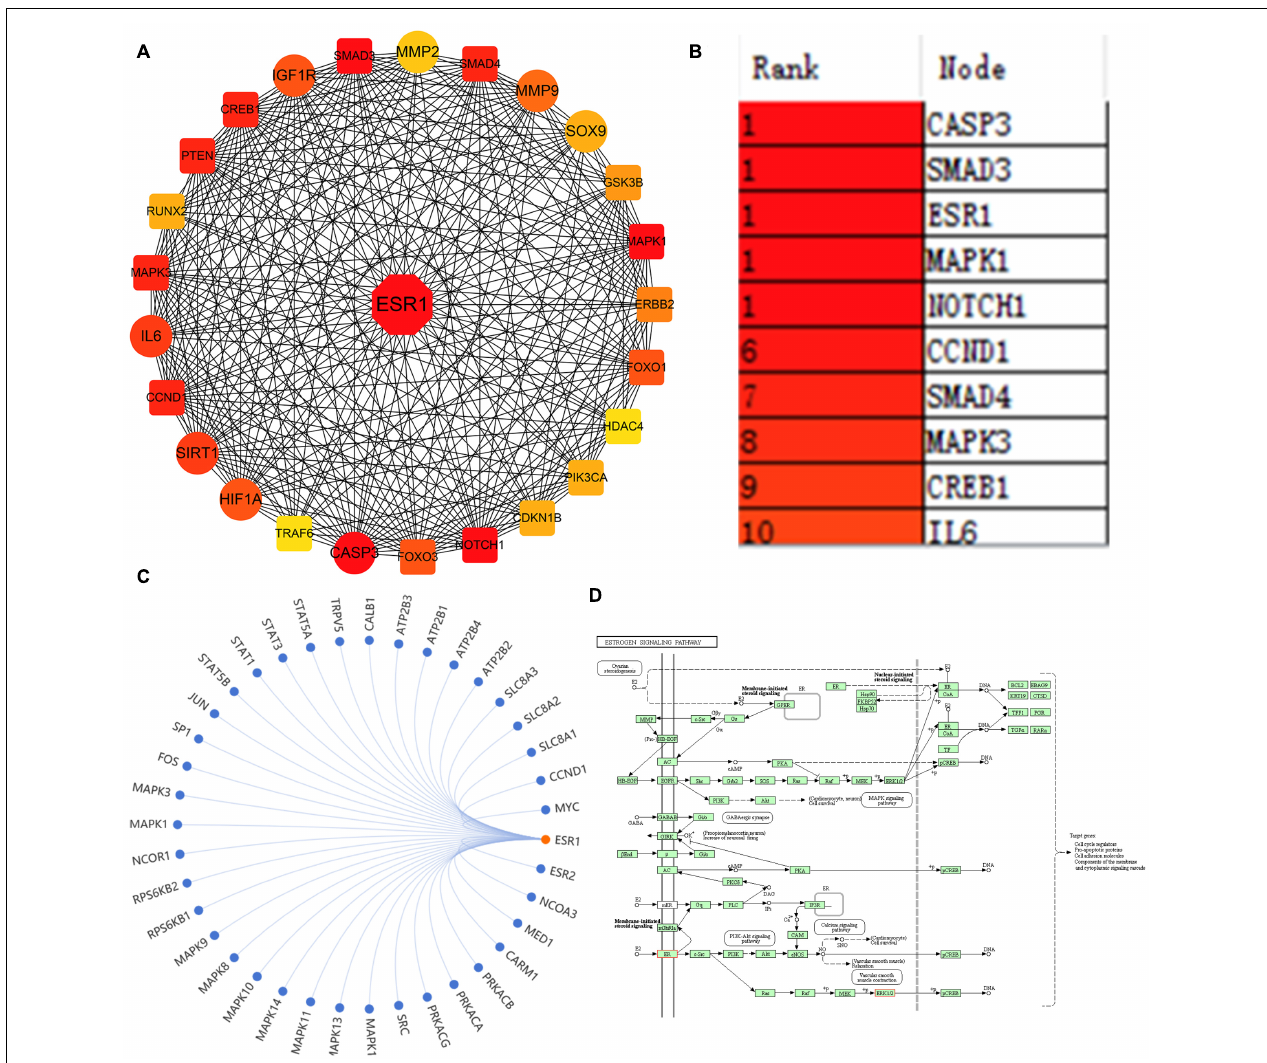
FIGURE 1 | ESR1 was identified as one of the most critical genes in IDD. (A) PPI network showing IDD-related miRNA target genes. The line between the circle nodes indicates the interaction between the two genes. Red indicates the most key hub genes; the depth of the color is related to the association of other genes in the PPI network. (B) Top 10 genes in the PPI network ranked by the maximal clique centrality method, of which ESR1 ranked the highest. (C) Other genes regulated by ESR1 were predicted and visualized using the SangerBox tool. (D) Kyoto Encyclopedia of Genes and Genomes analysis of estrogen signaling pathway displayed that ESR1 might be involved in regulating various